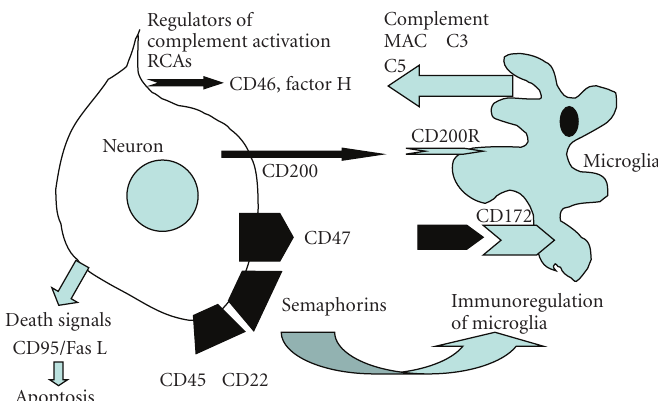
Figure 3: Neurons express a wide range of “selfdefence” proteins and receptors that reduce inappropriate bystander attack from activated microglia. Semaphorin 3a and CD22, CD45 all reduce proinflammatory cytokine expression and inhibit microglial activity. The neuro immunoregulatory (NI Regs) CD200 and CD47 that interact with the their counter receptors CD200R and CD172 on microglia and myeloid cells, reducing microglial activation (Black arrows). Regulators of complement activation RCAs) such as CD46 also act as “don’t eat me” signals preventing attack from host microglia. Neurons also express “Death signals” to initiate apoptosis in damaged cells or infiltrating T cells making them targets for